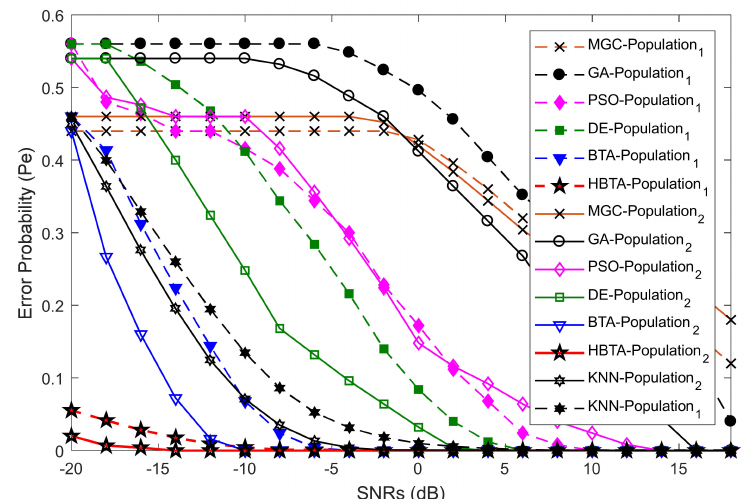
Figure 18. Error probability vs. SNRs in the presence of AO-AOC users with population 1 (30) and population 2 (55).